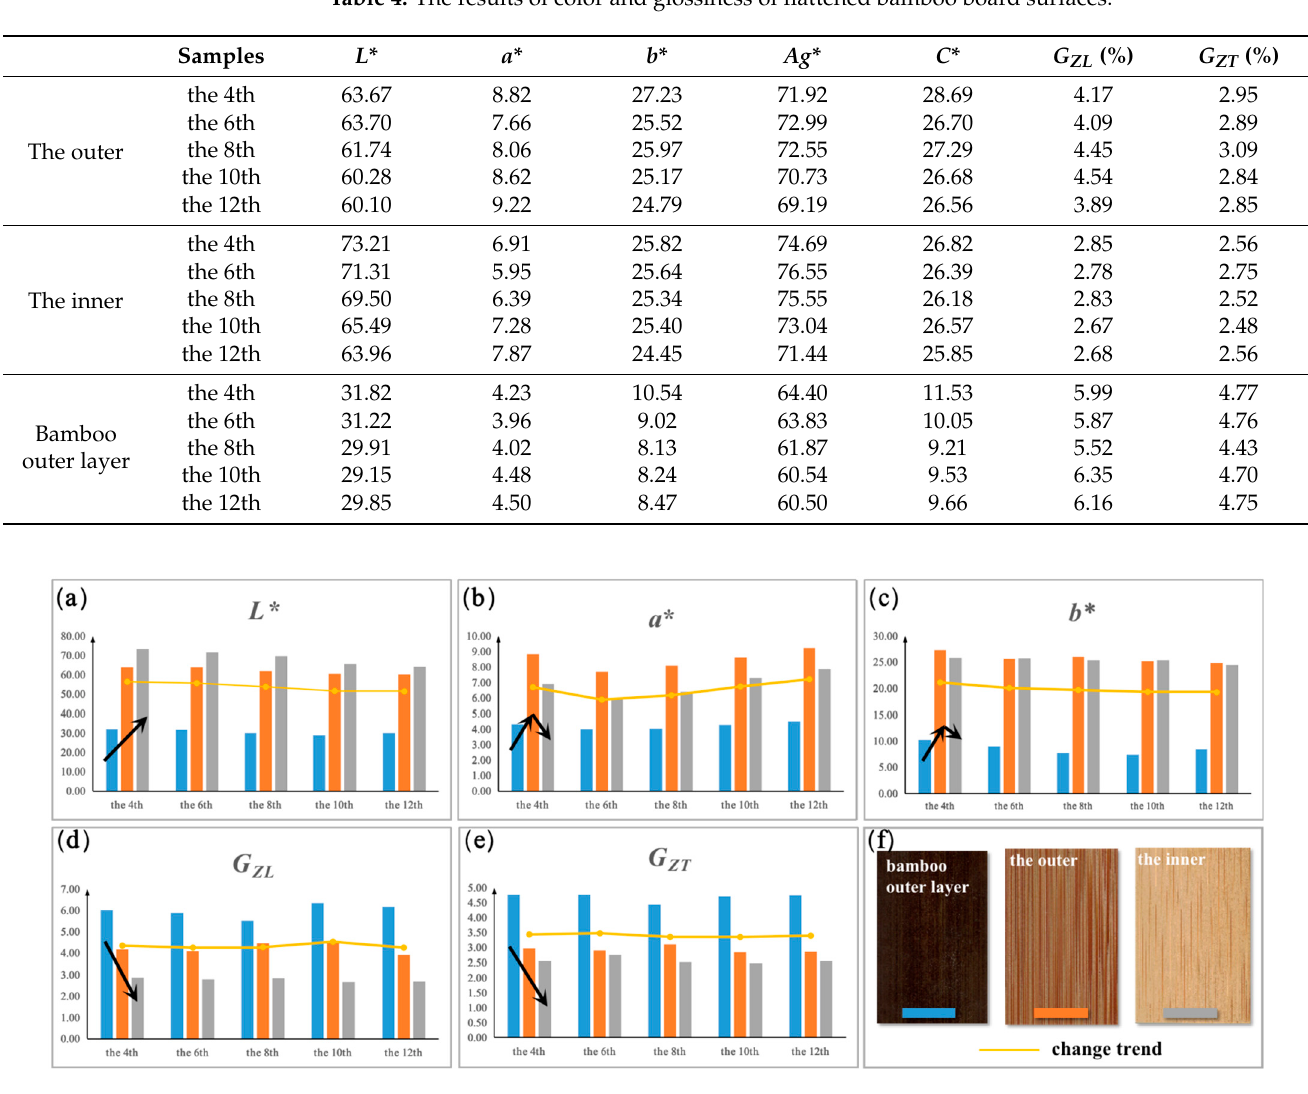
Figure 3. The changing treed and difference of visual physical quantities in different bamboo culm parts. ( a – e ) corresponding to variation trends of L* , a* , b* , G ZL and G ZT parameters, ( f ) the macro images of three types of flattened bamboo boards. Black arrow refers to the variation trend of each visual physical quantity among three types of boards; the orange dotted broken line indicates the change trend of each visual physical quantity at different internodes.